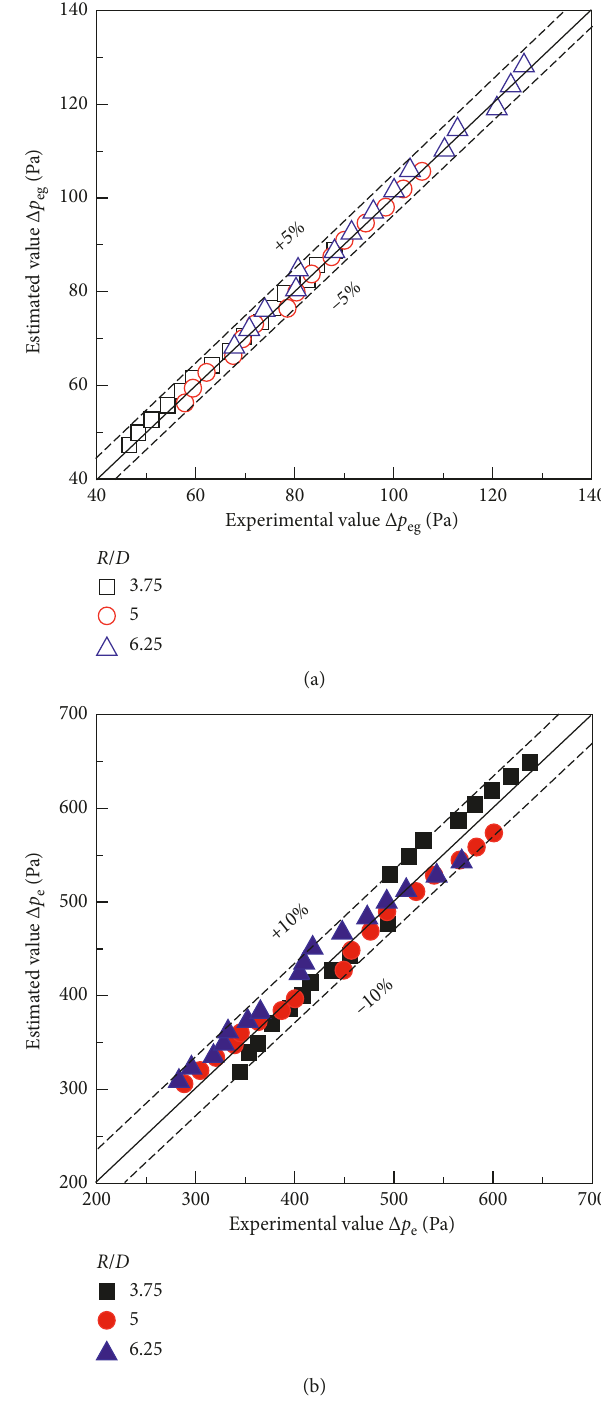
Figure 11: The deviation between the experimental value and the predicted value of the local pressure loss of gas-solid